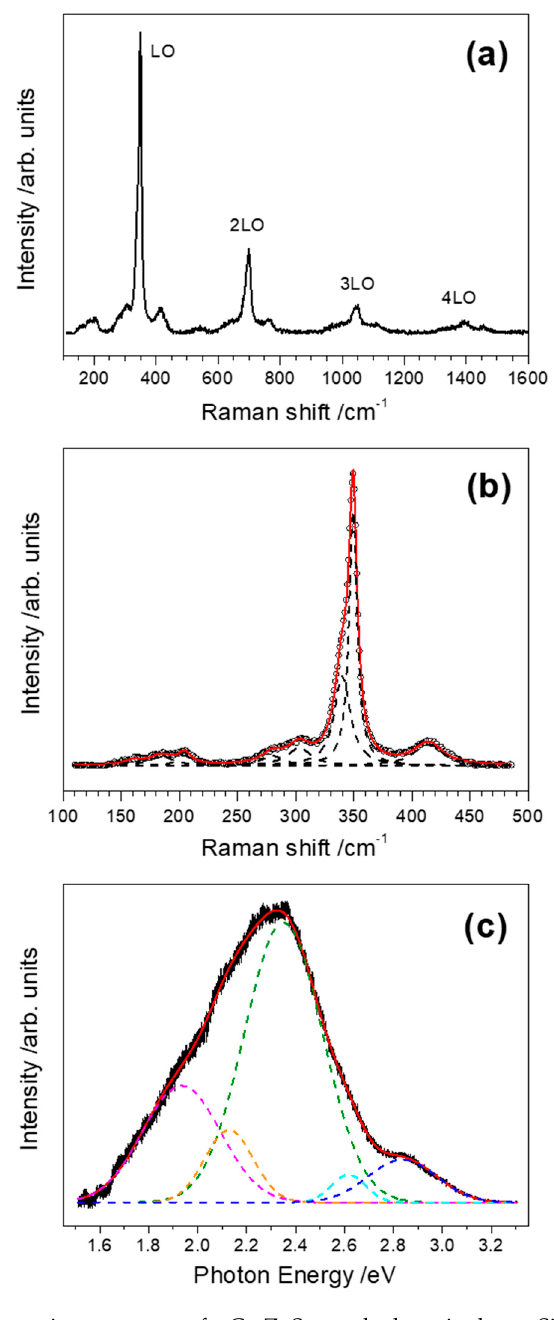
Figure 5. ( a ) Raman scattering spectrum of a Co:ZnS sample deposited on a Si substrate with 2 × 10 6 double pulse sequences and an interpulse delay of 10 ps. ( b ) Lorentzian deconvolution of the Raman spectrum in the (100–500) cm − 1 range. Circles represent the experimental data while the red solid line corresponds to the best-fit curve. ( c ) Room-temperature photoluminescence (PL) spectrum of the same sample. Gaussian deconvolution reveals emission bands centered at 2.84, 2.62, 2.35, 2.13, and 1.93 eV (dashed lines). The black line corresponds to the experimental data while the red solid line corresponds to the best-fit